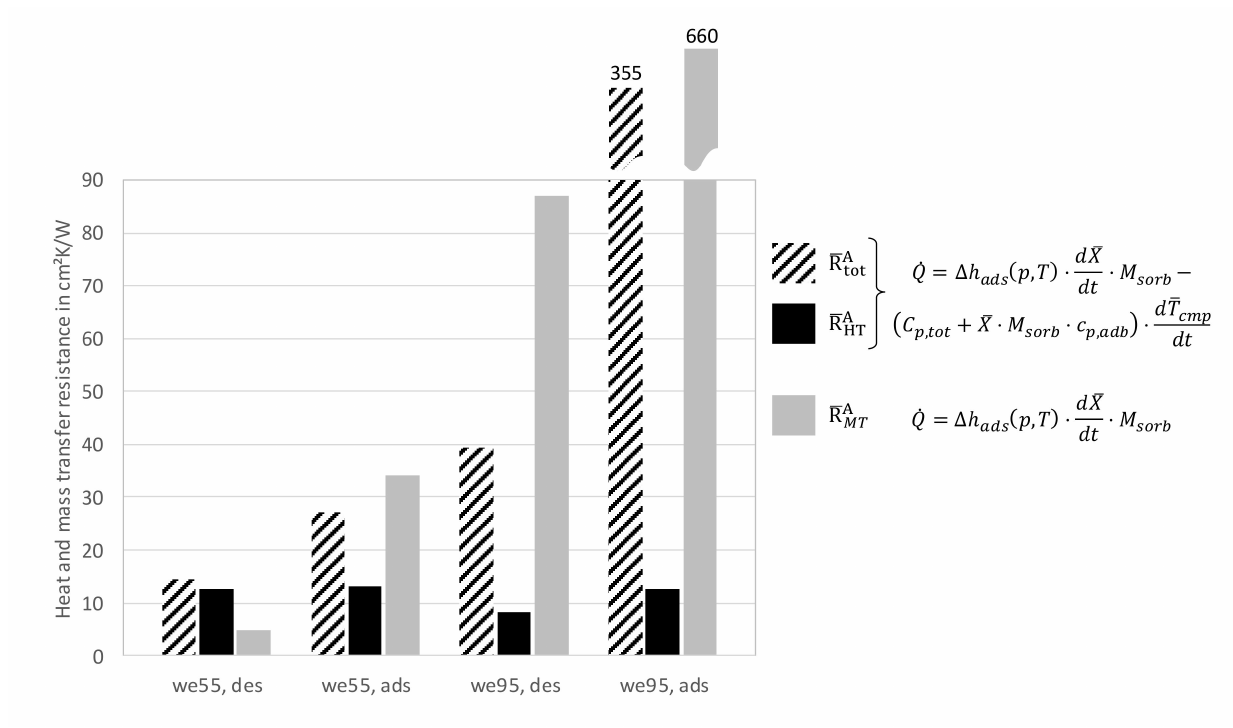
Figure 11. Heat and mass transfer resistances scaled with the sample area R A of sample we55 and sample we95. The two heat flux term formulations are given here according to Equation